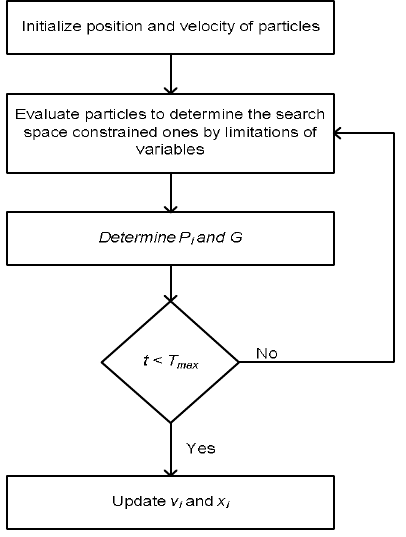
Fig. 2. Standard PSO flowchart